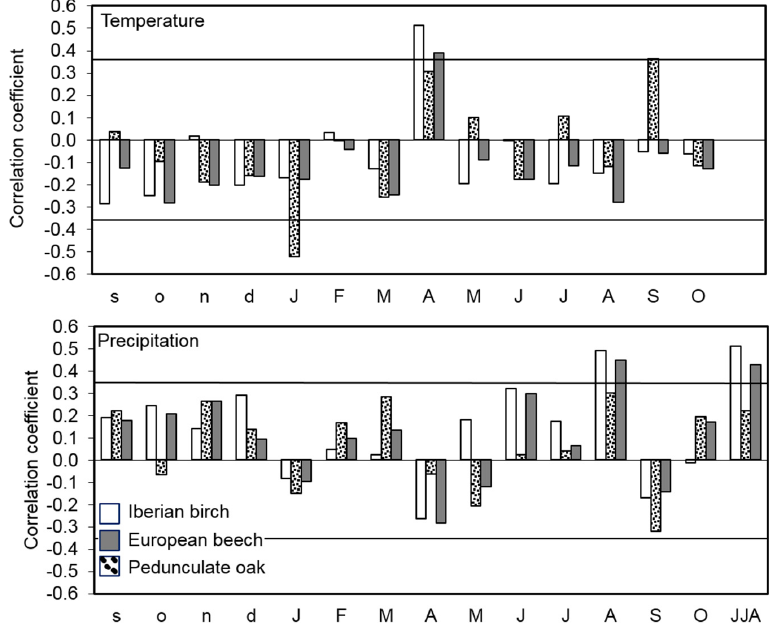
Figure 3. Pearson correlations between the indexed ring ‐ width residual chronologies and monthly mean temperature and precipitation for the period between previous September and October of the growth year. Lowercase letters indicate the months before tree ‐ ring formation, and the uppercase letters indicate months of the year of tree ‐ ring formation. JJA (June ‐ July ‐ August) indicates summer precipitation (from June to August). The horizontal lines indicate the significance level ( p < 0.05).